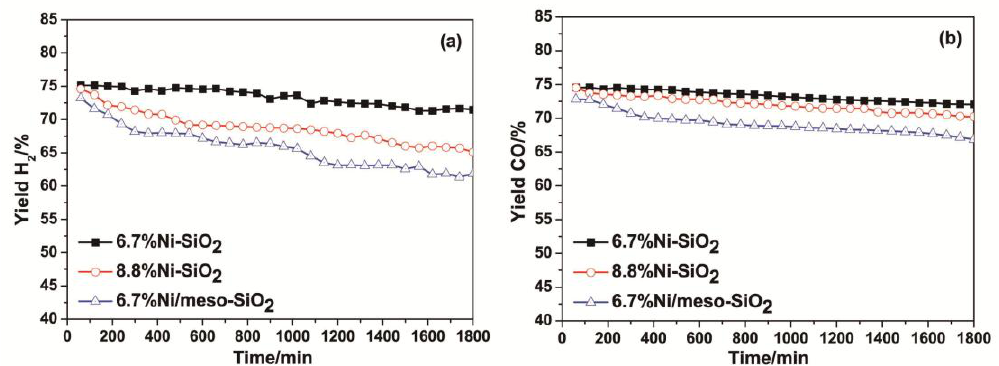
Figure 8. Catalytic stability test for 6.7%Ni-SiO the dry reforming of methane with carbon dioxide at 650 °C for 30 h with a GHSV of 24,000 mL∙h −1 ∙g −1